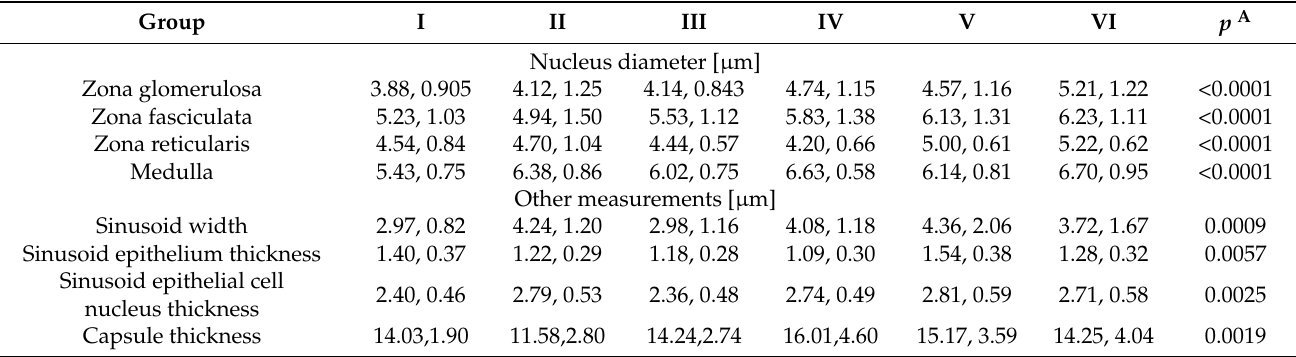
Table 2. The values of the measurements (median, IQR) by